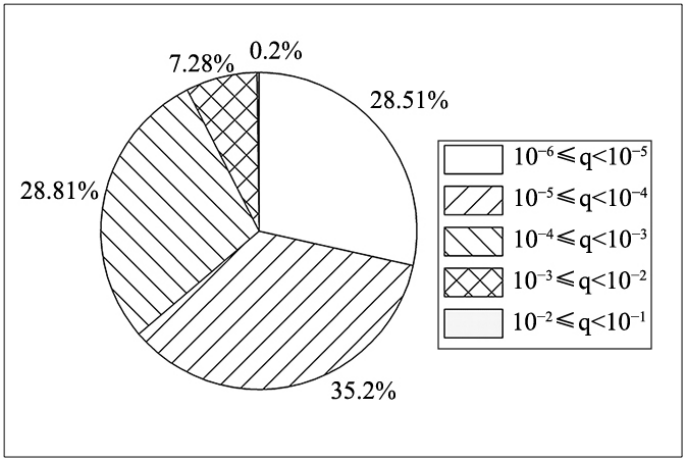
Figure 1. European dataset distribution.